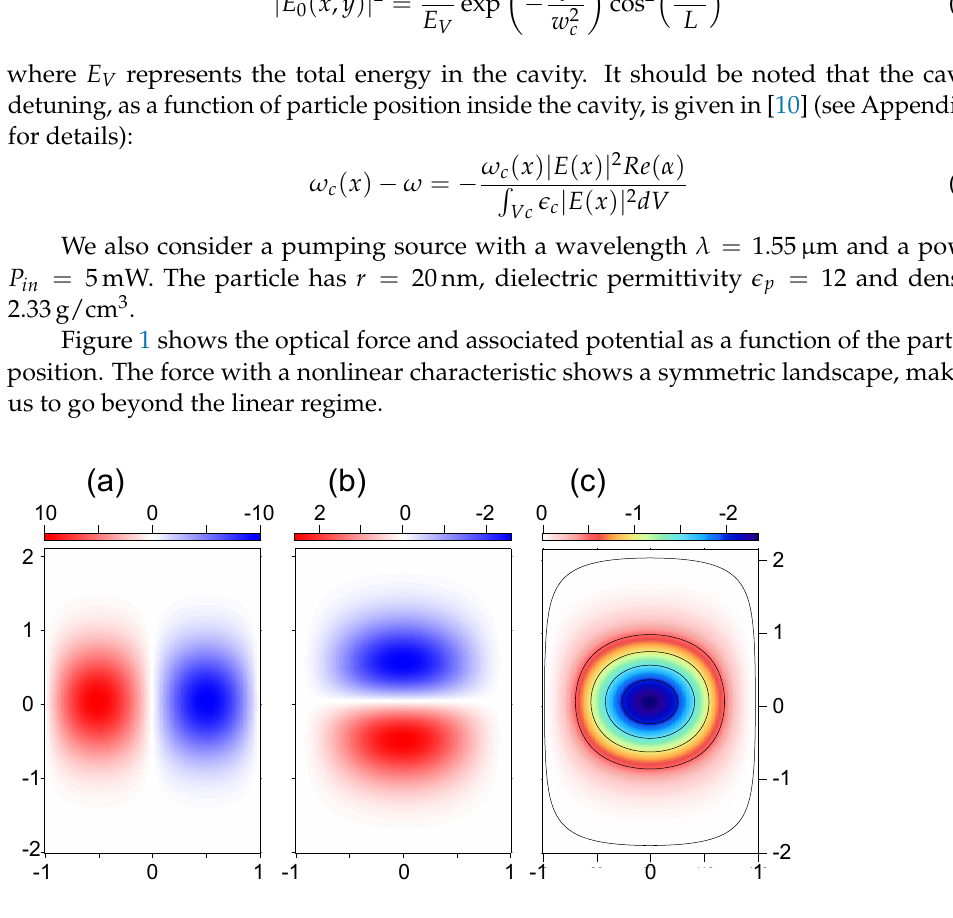
Figure 1. ( a ) Force x-component ( F x ). ( b ) Force y-component ( F y ). ( c ) Potential energy of the particle in the cavity. Black color lines represent equipotential lines. Horizontal axis in units of L /2. Vertical axis in units of w c . Force in pN. Particle potential energy in units of